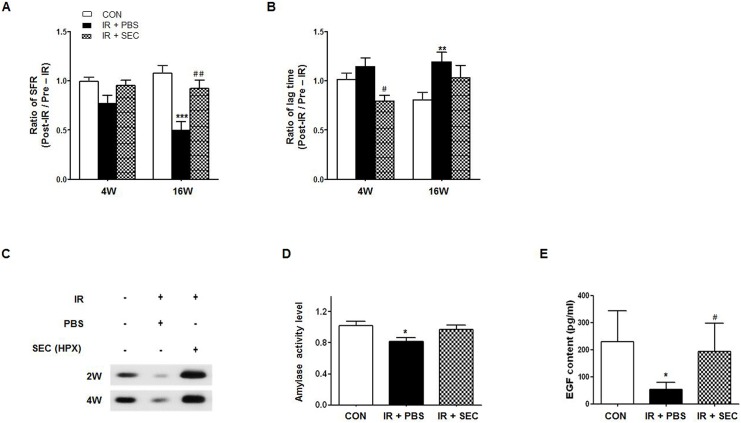
Recovery of salivary hypofunction by hAdMSC secretome infusion.(A) Salivary flow rate (SFR) was calculated at pre-IR and 4 and 16 weeks post-IR. The changes in SFR after IR were expressed by the ratio of post-IR SFR to pre-IR SFR (Mean ± SEM). (B) Time to salivation (lag time, LT) was measured and the ratios of post-IR LT to pre-IR LT were presented. (C) Western blotting of amylase in saliva at 2 and 4 weeks post-IR. (D) The salivary amylase activity was examined by the Assay Kit and fold changes in activity level are presented. (E) EGF contents were measured at each time point and the average contents are presented. Data are presented as the mean ± SEM. Two-way ANOVA, Bonferroni post hoc test (A and B), one-way ANOVA, Tukey’s pot hoc test (D and E). *, compared to CON; #, compared to IR + PBS. *P <0.05, **P < .01, ***P <0.001, #P < 0.05, and ##P < 0.01. CON, normal control group (n = 5–7); IR + PBS, PBS-treated group (n = 5–6); IR + SEC, secretome-treated group (n = 5–6).